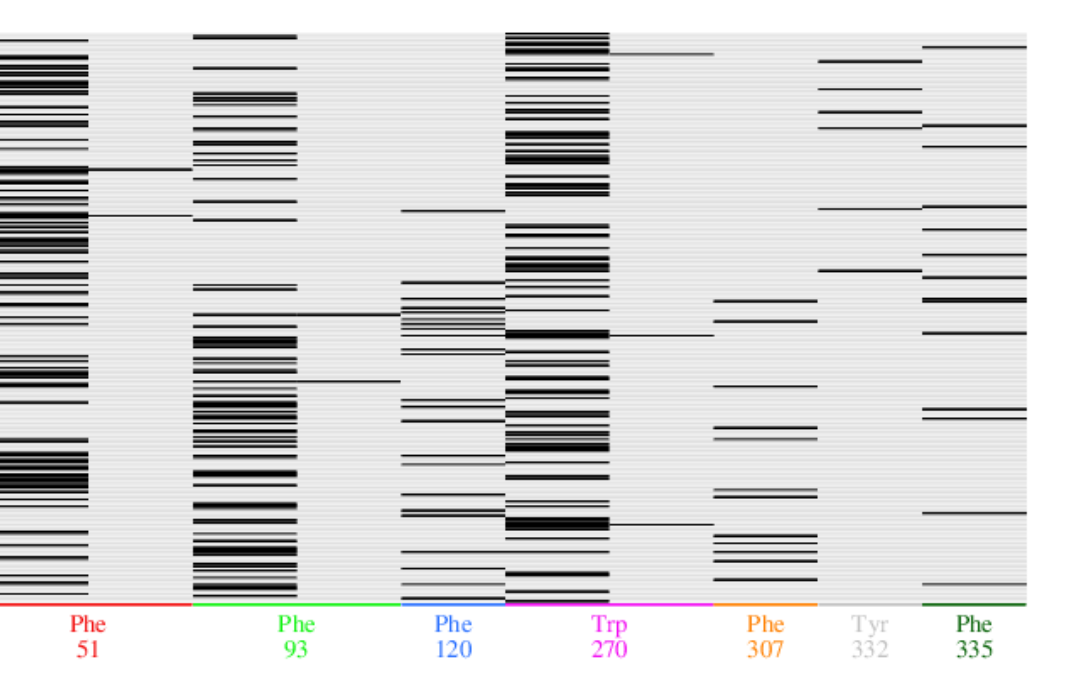
Figure 5. ( a ) Potential energy surface over the β-carotene and the BCO1 residues with which it in- teracts, according to PLIF analysis. The hydrophobic areas are colored in green and the hydrophilic areas in red. ( b ) Two-dimensional representation of the interactions established by β-carotene